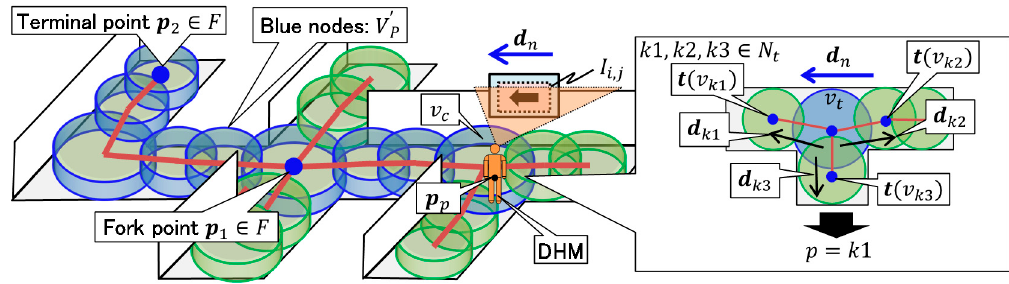
Figure 8. Extraction of fork points from navigation graph.